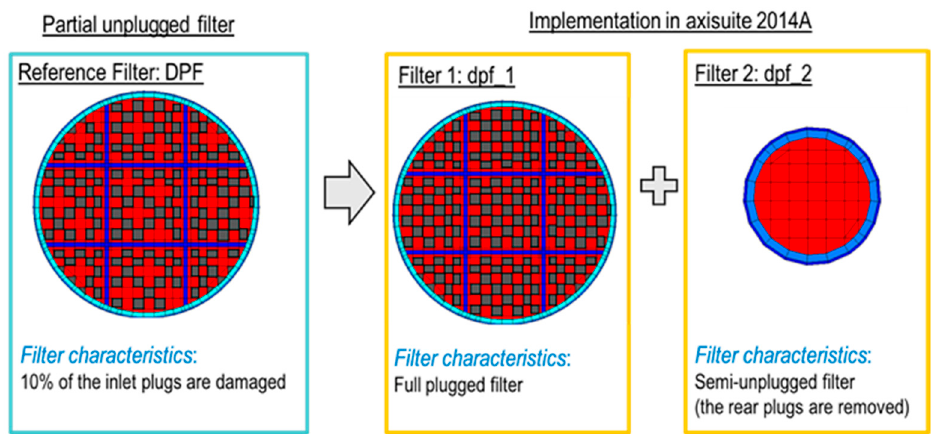
Figure 8. Simulation of a partial unplugged DPF (Axisuite).